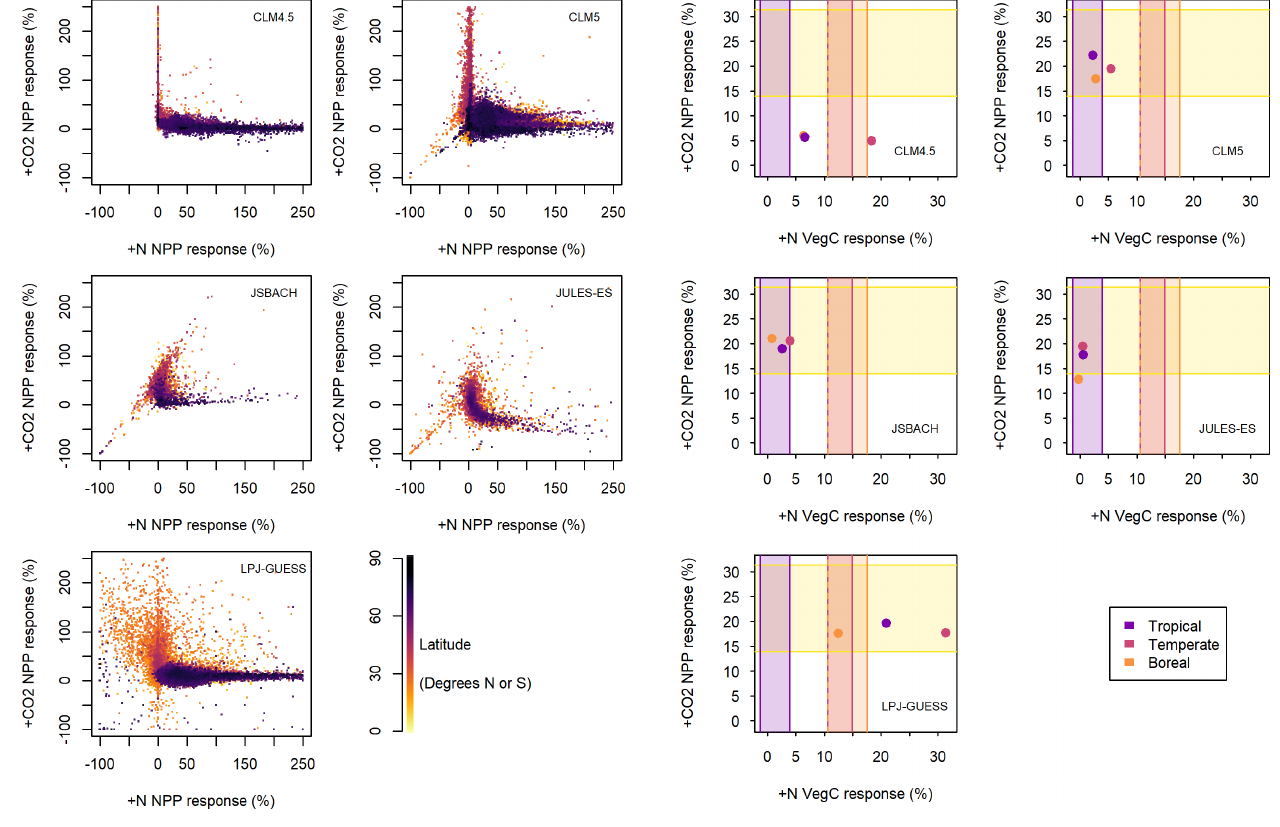
Figure 4. Model estimates of 1996–2005 mean net primary produc- tivity (NPP) response to + N vs. + CO 2 , as a percent anomaly of the control scenario. Each grid box is plotted against the correspond- ing grid box for the other variable. The percent change is capped at 250%, and values above are not plotted. The colour of the points indicates the latitude: either north or south.